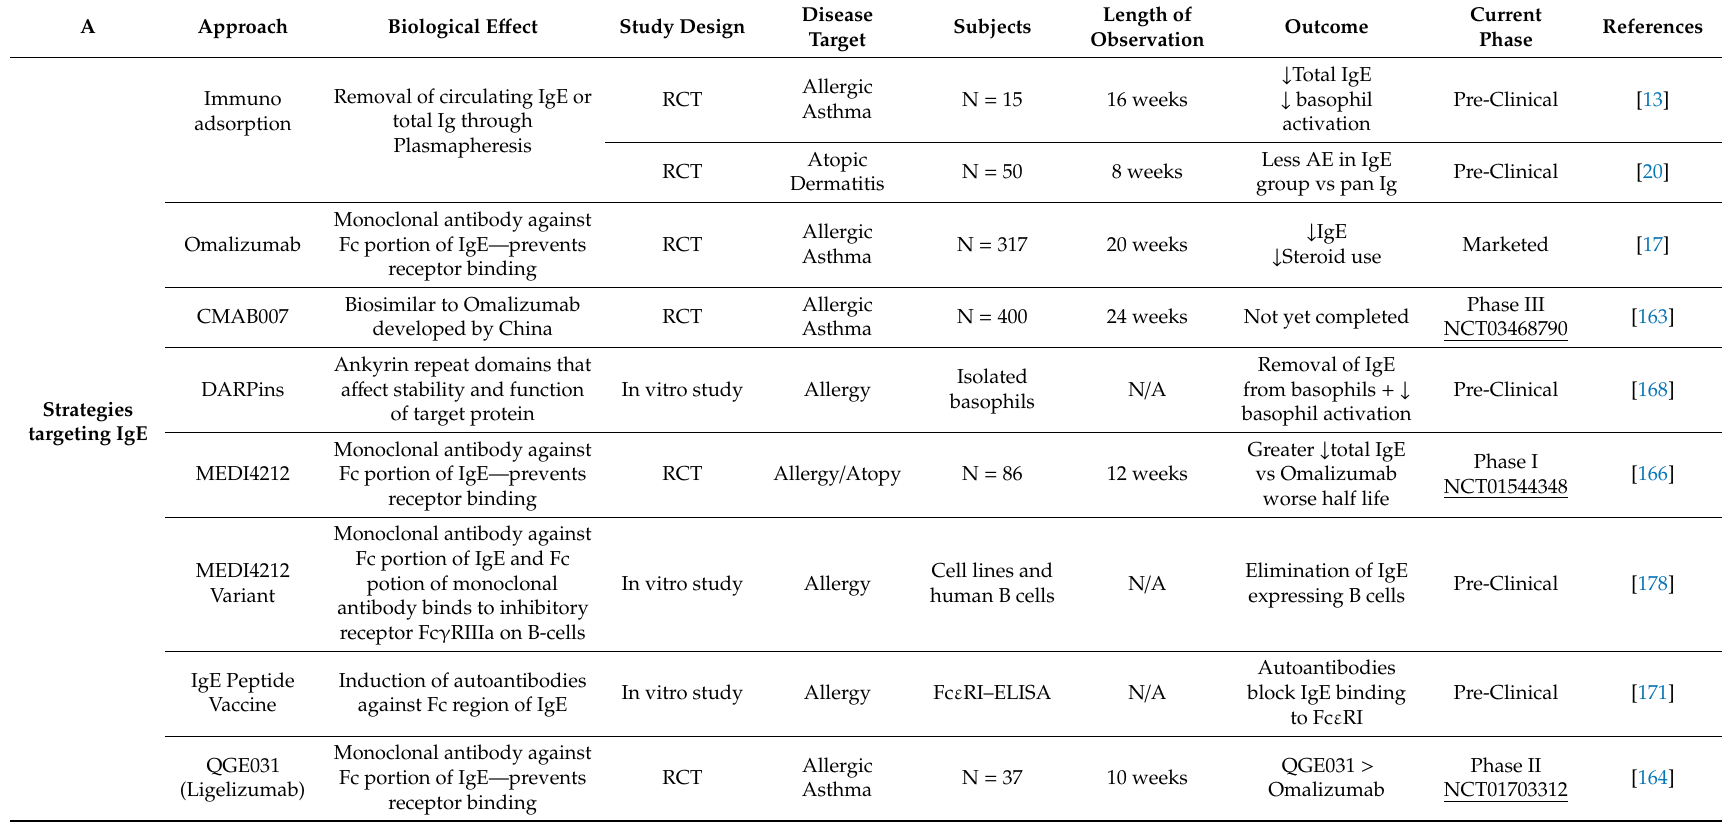
Table A1. ( A ) Therapeutic approaches targeting e ff ector IgE + and IgE producing cells. Randomised Control Trial (RCT), Adverse Event (AE). ( B )